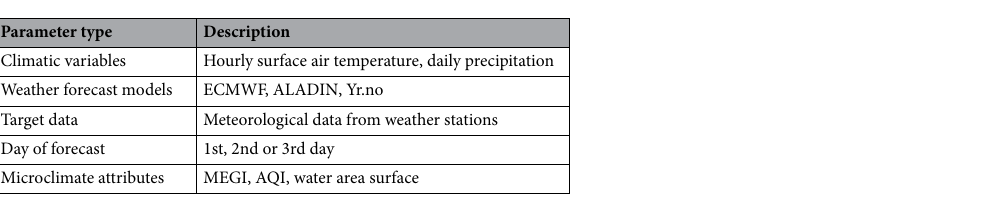
Table 2. List of dataset